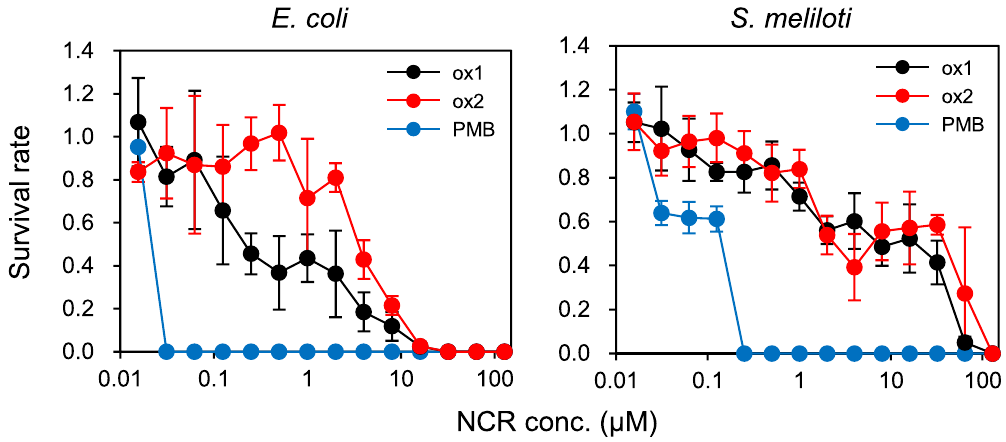
Figure 4. M. truncatula NCR169 has antimicrobial activity against Escherichia coli K-12 and its symbiotic partner Sinorhizobium meliloti . Bacteria ( S. meliloti and E. coli K-12) were treated with various NCR169 peptide (NCR169-ox1 and -ox2) and PMB concentrations, and survival rates were calculated based on untreated bacteria. All experiments were repeated at least four times. Error bars represent standard deviation